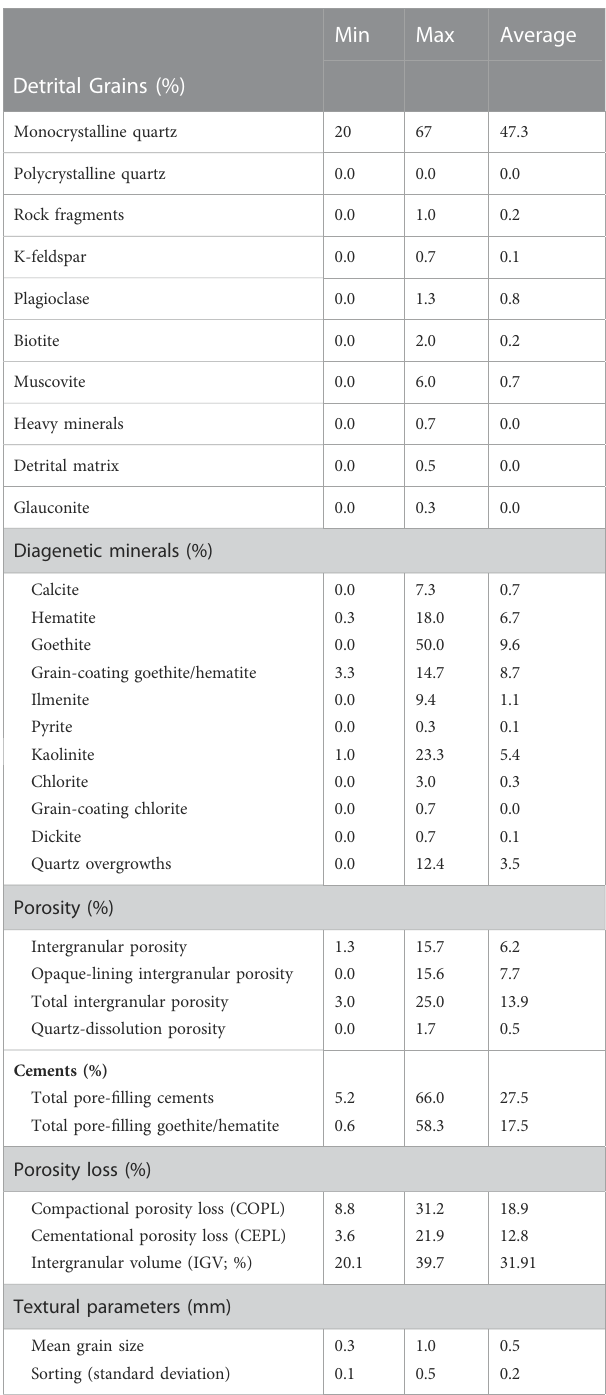
TABLE 1 Petrographic point-count